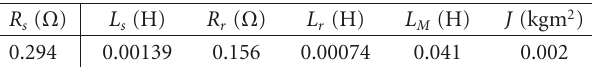
Table A.6: Parameters of a six-pole induction motor of test sys-